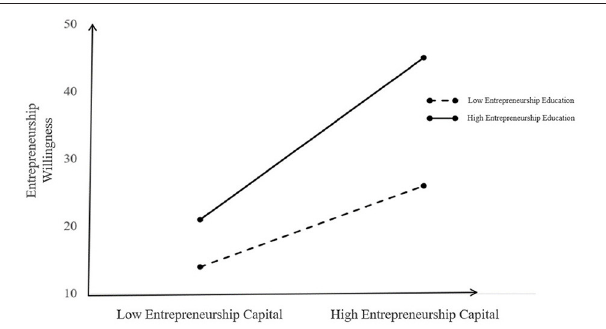
FIGURE 3 | Regulated intermediary model. *** p < 0.01.